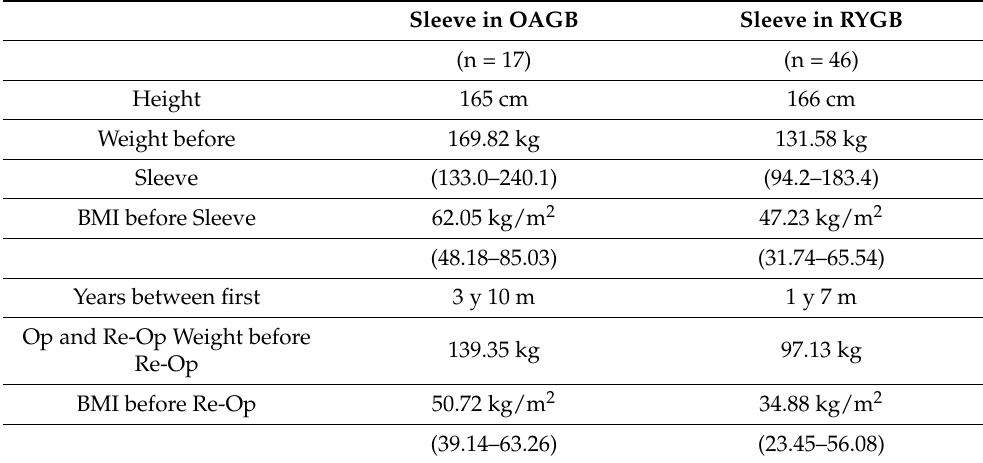
Table 1. Short overview of the two